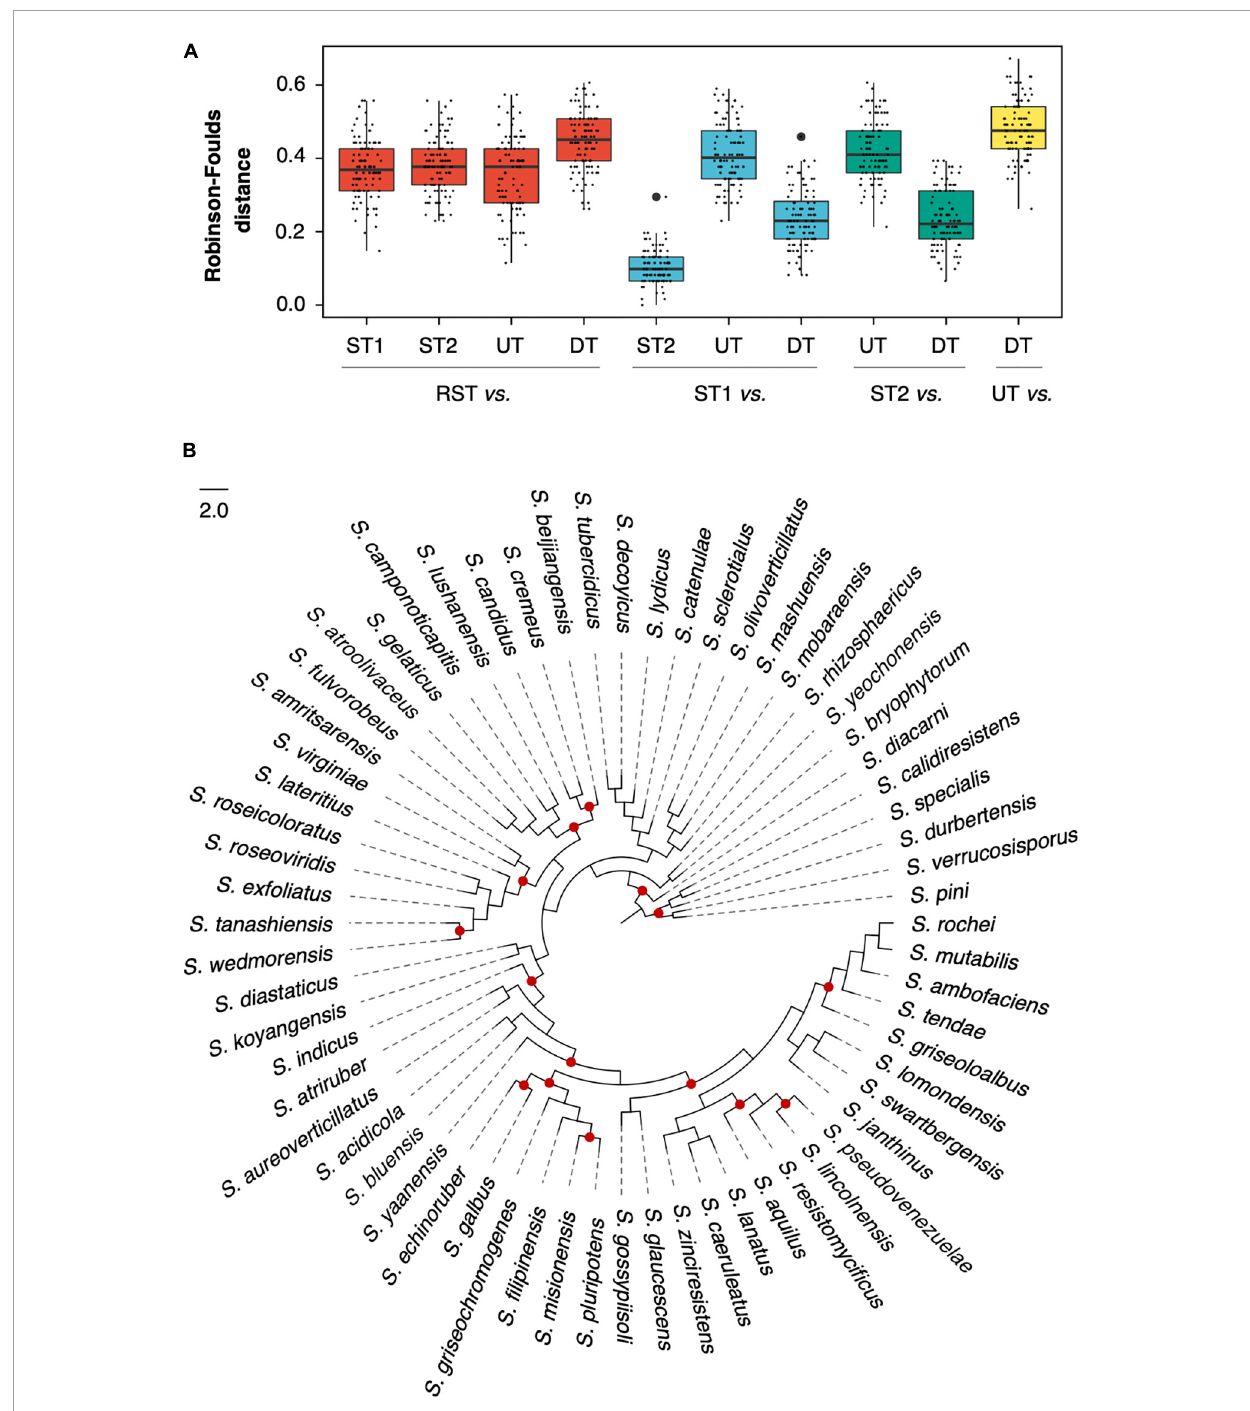
FIGURE3 Topological comparison among species trees and concatenated maximum likelihood (ML) trees. (A) Robinson-Foulds distance between two compared trees in one of 100 random genome datasets (RGDs); (B) the species tree of RGD008 based on the supermatrix approach. The red dots represent where the phylogenetic conflict between DT and ST1